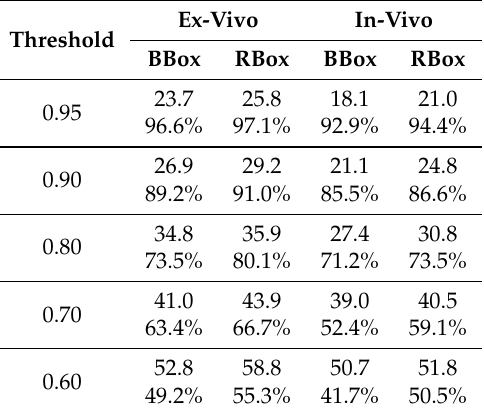
Table 1. Number of detections and